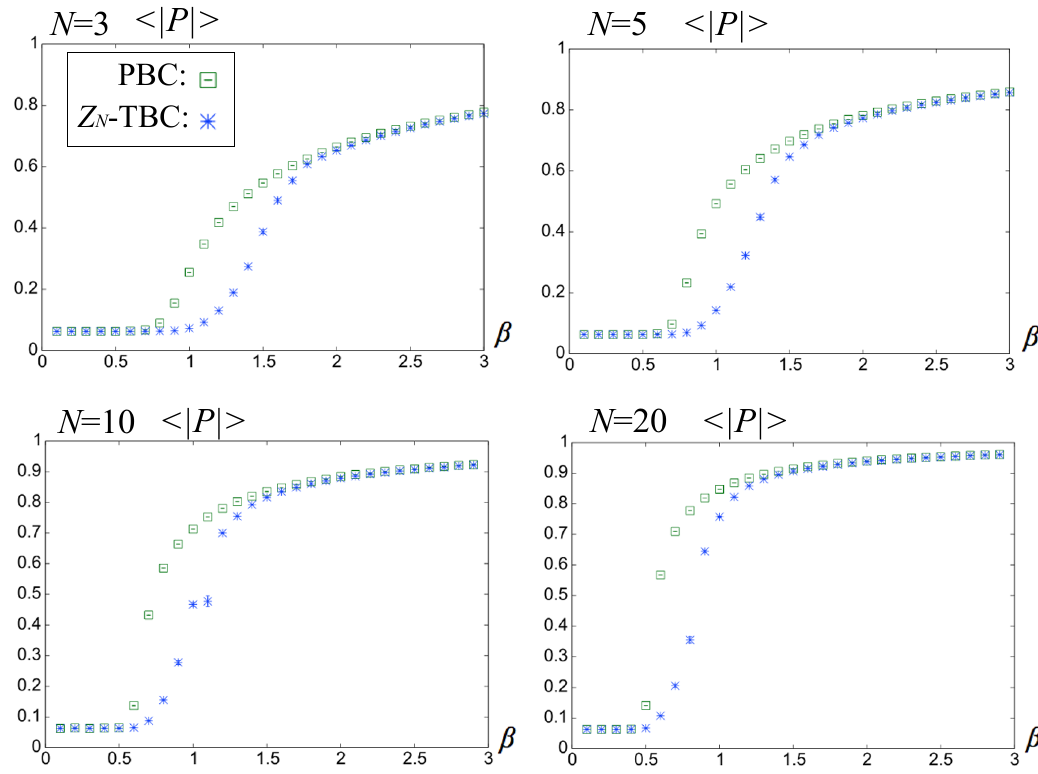
Figure 8 . The expectation values of the absolute values of the Polyakov loop for the Z N -TBC and PBC with N = 3 ; 5 ; 10 ;